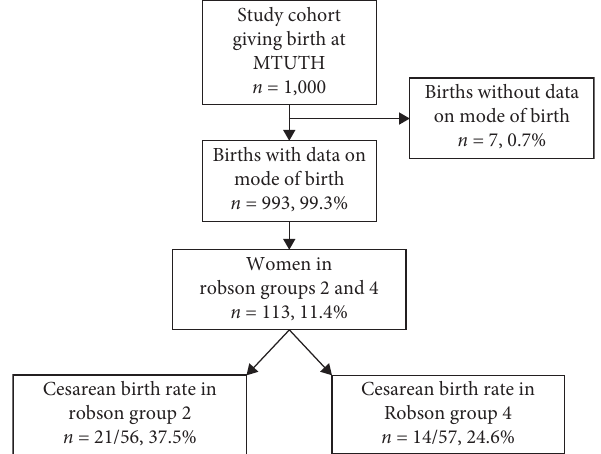
Figure 1: Women giving birth by cesarean in Robson Groups 2